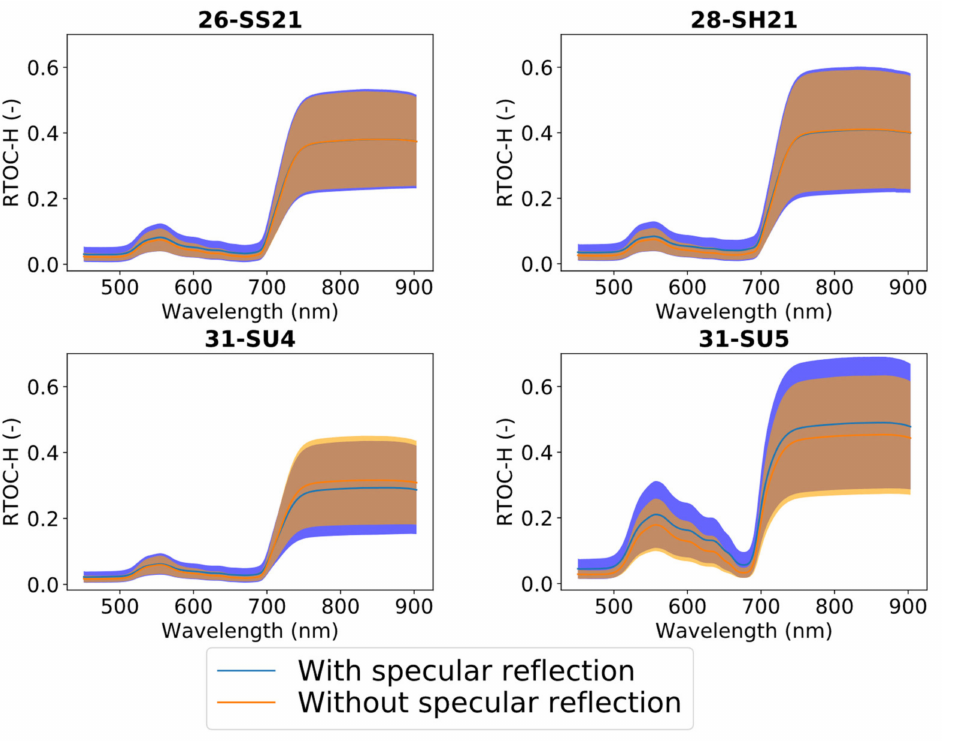
Figure 7. Assessment of the impact of specular reflection on the top-of-canopy reflectance (R TOC-H ). Blue and orange lines represent the entire image mean value including and excluding those pixels affected by specular reflection, respectively. Shaded areas indicate the two-sided standard deviations. Top-of-canopy reflectance was computed using the horizontal white reference